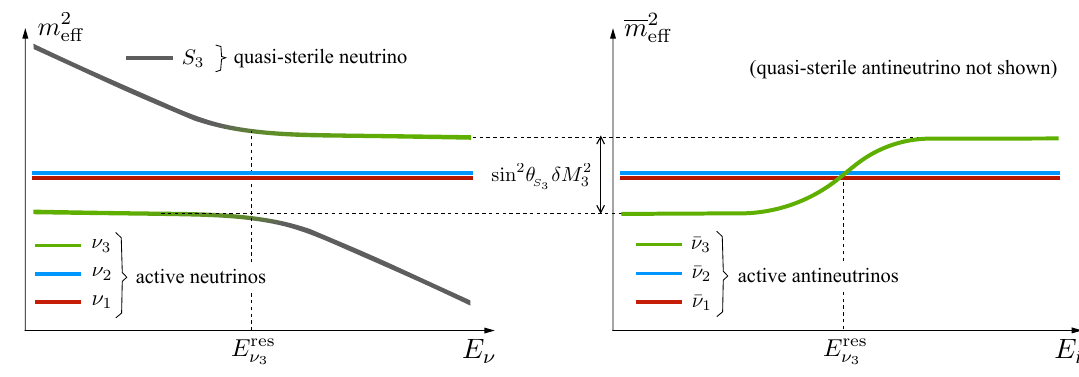
Figure 3 . [ For illustration purposes only — not to scale ] Effective mass-squared eigenvalues of neutrino propagation eigenstates (left panel) and antineutrino propagation eigenstates (right panel) as a function of (anti-)neutrino energy in the quasi-sterile neutrino toy model. The eigenstates’ flavor compositions are denoted by their color